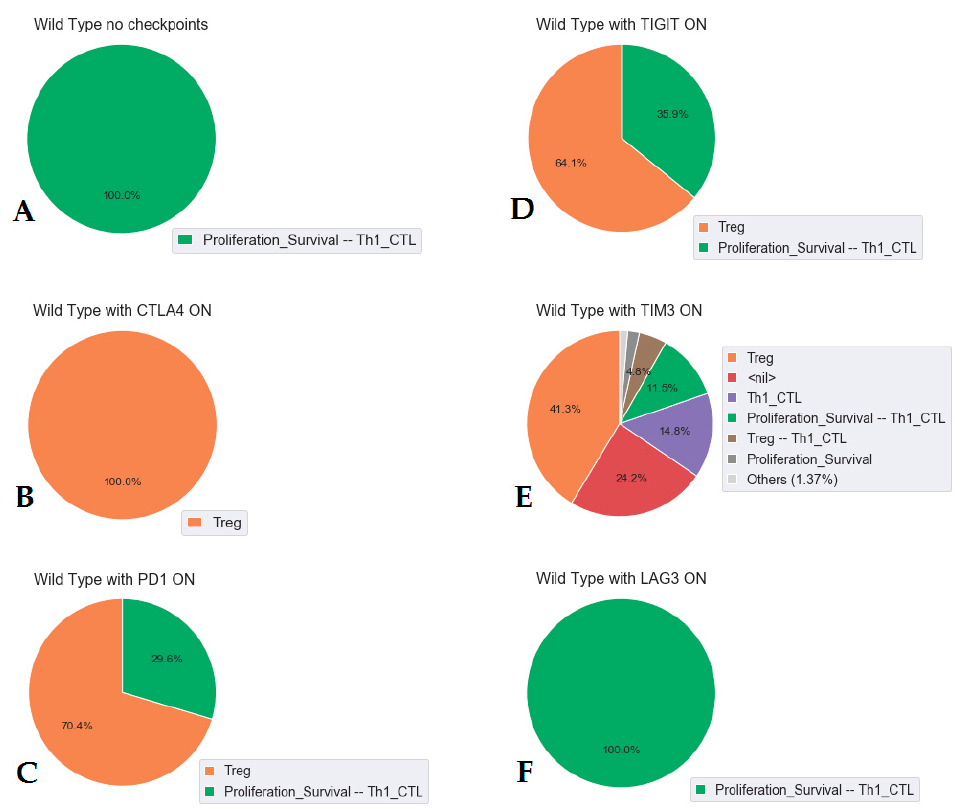
Figure 3. Impact of the presence of individual immune checkpoints on the fate of T cells. The model is simulated with no immune checkpoint ( A ), with only CTLA4 ligands ON ( B ), with only PD1 ligands ON ( C ), with only TIGIT ligands ON ( D ), with only TIM3 ligands ON ( E ), and with only LAG3 ligands ON ( F ). In the legend, the presence of a phenotype means that it corresponds to the asymptotic solution of the simulations in all the conditions (from B – F ). If Treg is mentioned, it should be understood as: Treg is ON, but Proliferation_Survival and Th1_CTL are OFF.